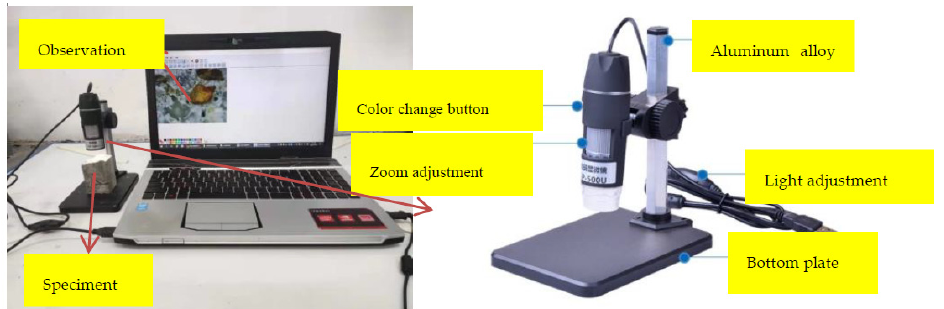
Figure 4. Schematic diagram of microscope observation.